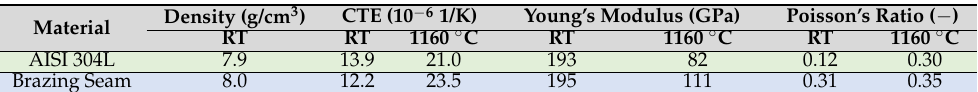
Table 4. Material properties calculated with the JMatPro software for different temperatures; RT = room temperature (T = 20 ◦ C).